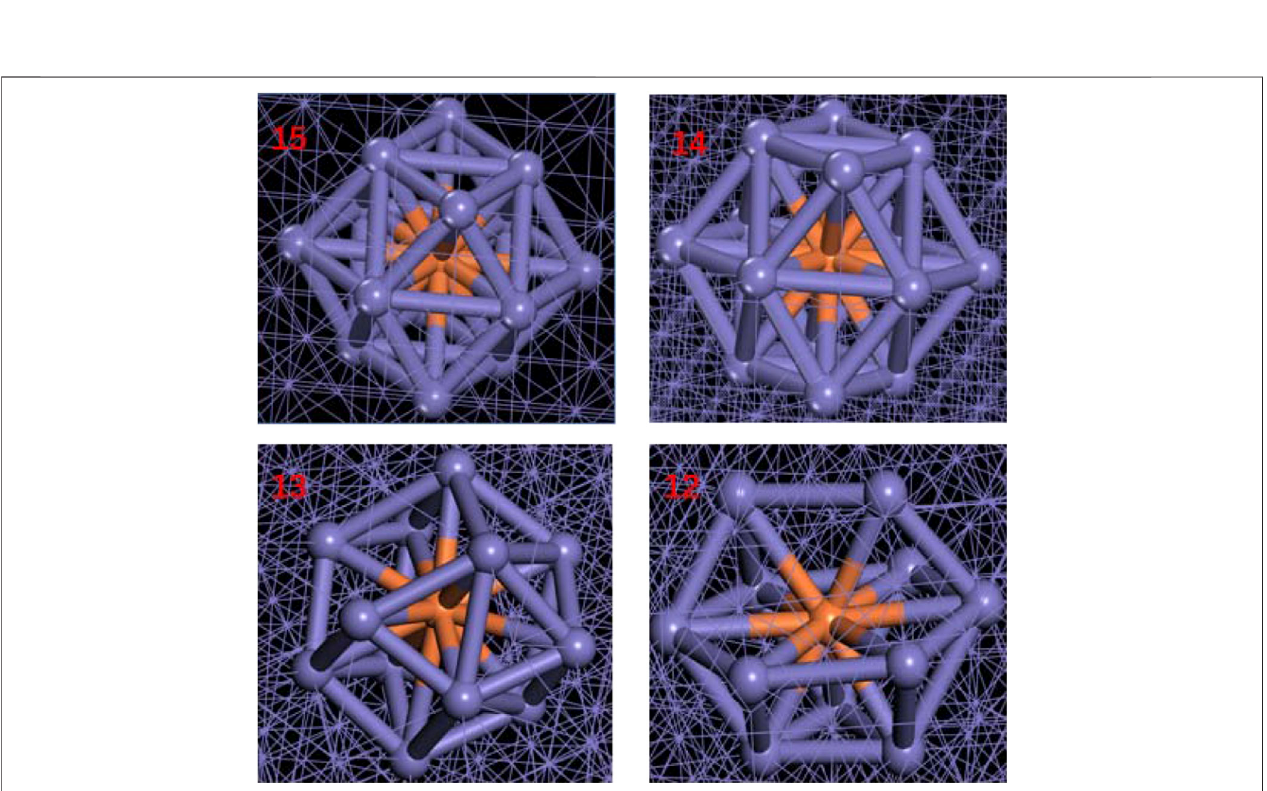
FIGURE 6 | Fe local structure diagrams with different coordination numbers. Color scheme: purple (cid:2) Fe; orange (cid:2) central Fe.